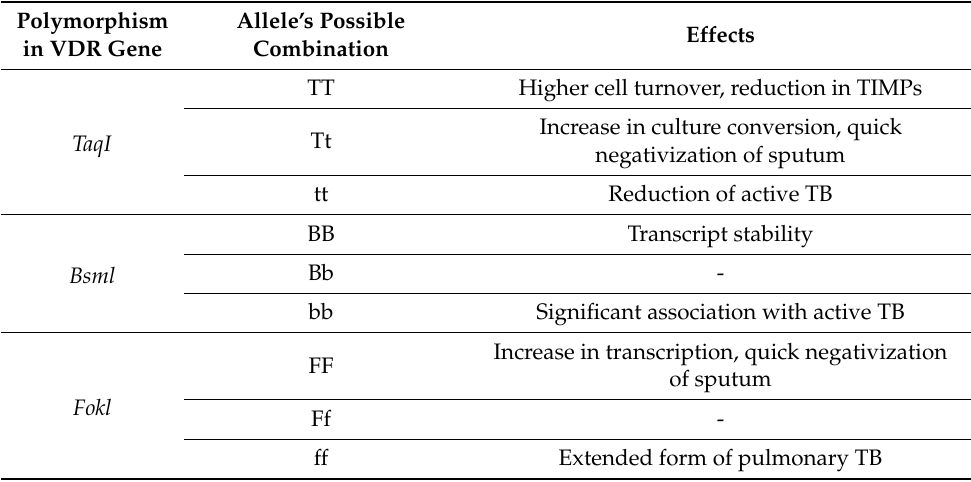
Table 3. Correlation between polymorphism in VDR gene and possible effects on